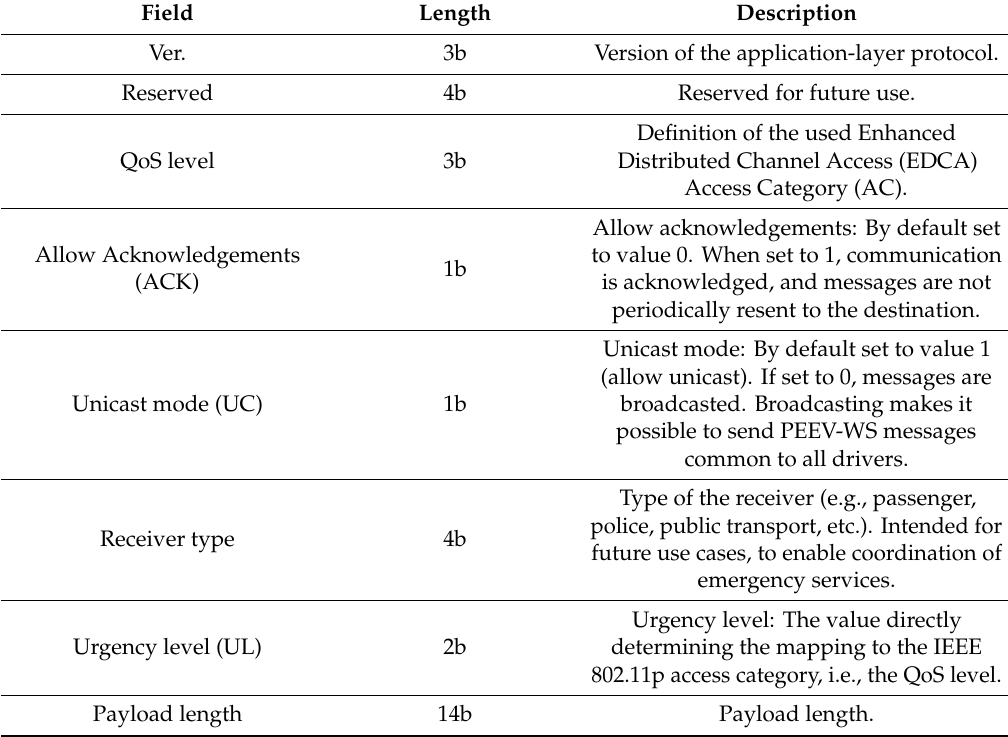
Figure 4. The message structure designed for the PEEV-WS. Table 2. Description of message format fields.